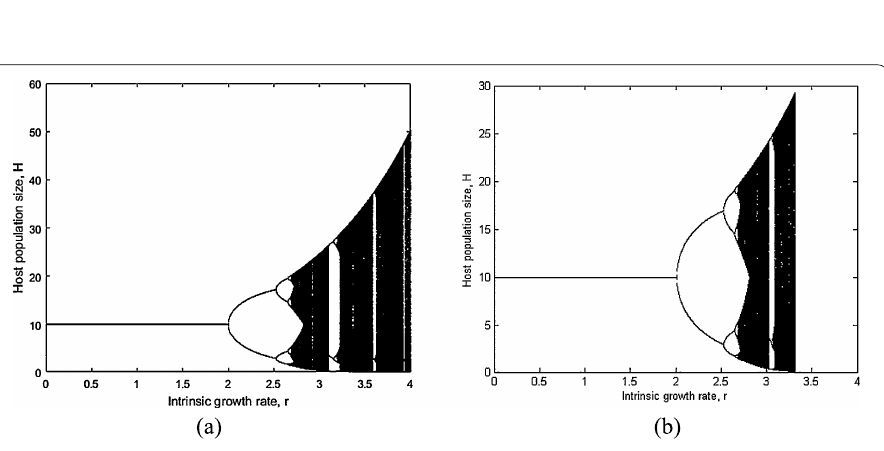
Figure 3 Numerical simulations of equation (3.1). ( a ) System (3.1) without Allee effect for varying r in range 0 ≤ r ≤ 4 and K = 10, T = 1, T n = 0.4, b = 0.05, c = 0.2, m = 0, n = 0; ( b ) System (3.1) with Allee effect. Initial value as ( x 0 , y 0 ) = (5,2.5), and m = 0.01, n =